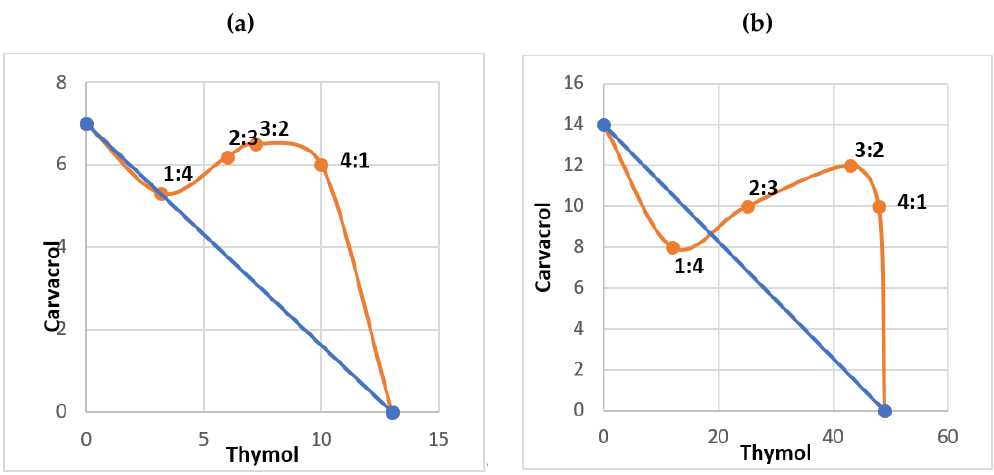
Figure 2. Isobologram of the interaction between carvacrol and thymol in binary combinations using the fixed ratio method: activity on eggs ( a ) and 3rd instar larvae ( b ) of Culex pipiens .